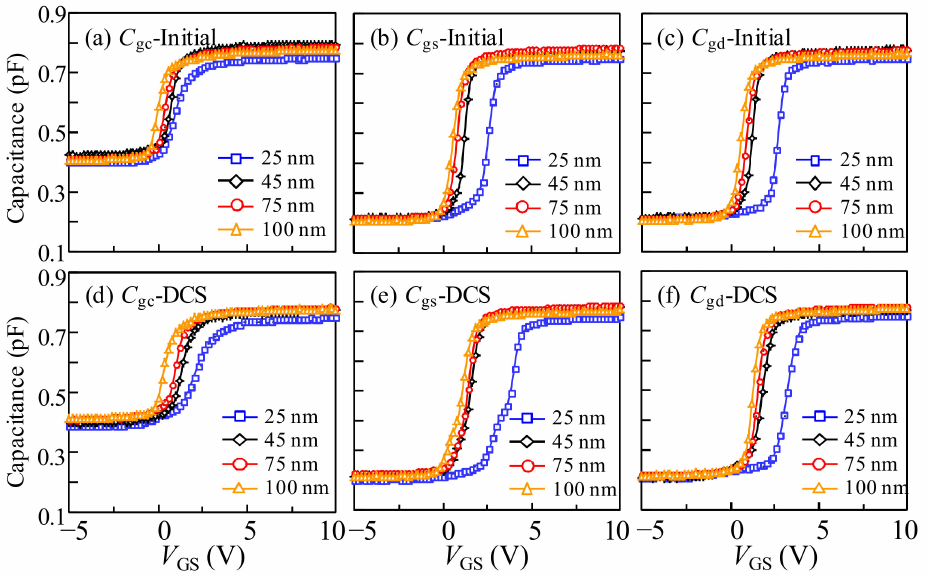
Figure 8. C – V curves of ( a ) C gc ; ( b ) C gs ; and ( c ) C gd in the initial and ( d ) C gc ; ( e ) C gs ; and ( f ) C gd after a DCS duration of 10 4 s with various T IGZO